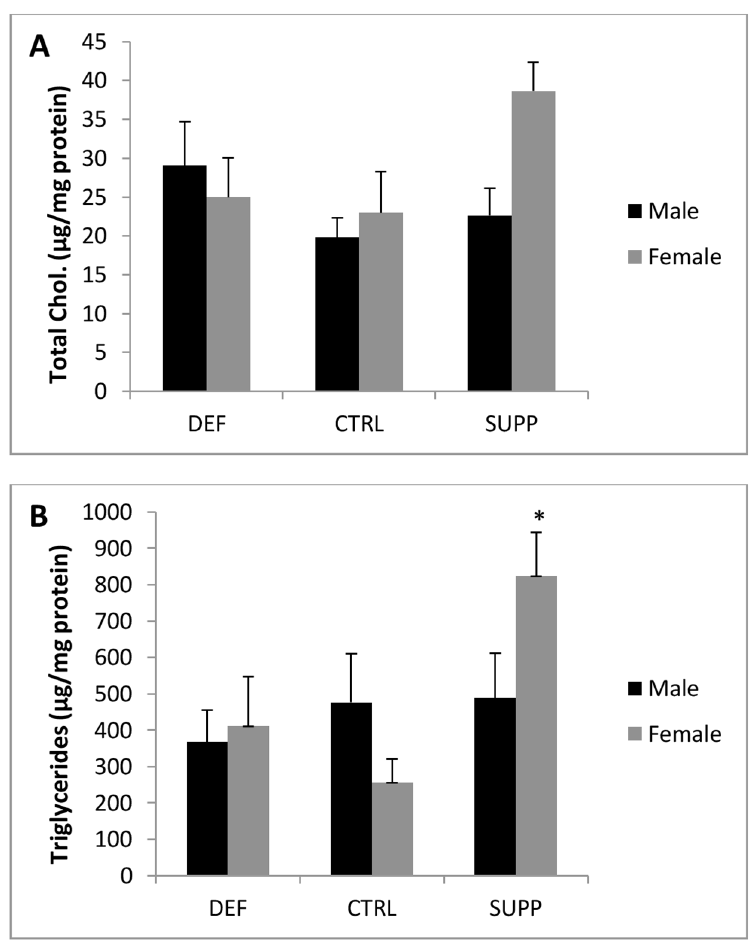
Fig 3. Hepatic lipid concentrations of adult Apc 1638N offspring of fathers fed diets differing in B vitamin content. A) Hepatic total cholesterol concentration. B) Hepatic triglyceride concentration. Paternal diets: DEF, B vitamin deficient; CTRL, B vitamin replete; SUPP, B vitamin supplemented. * denotes significant difference compared to CTRL of same sex (p < 0.05). n = 13 per diet group.